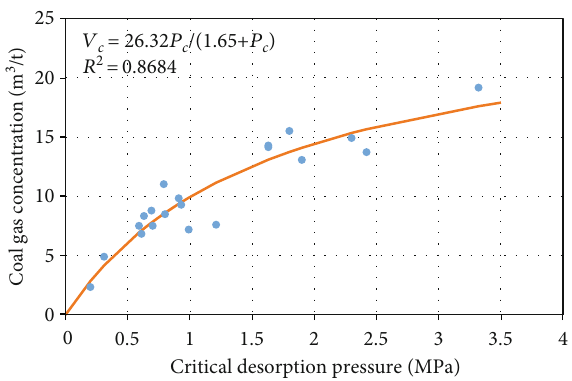
Figure 6: Relationship between critical desorption pressure and gas content.